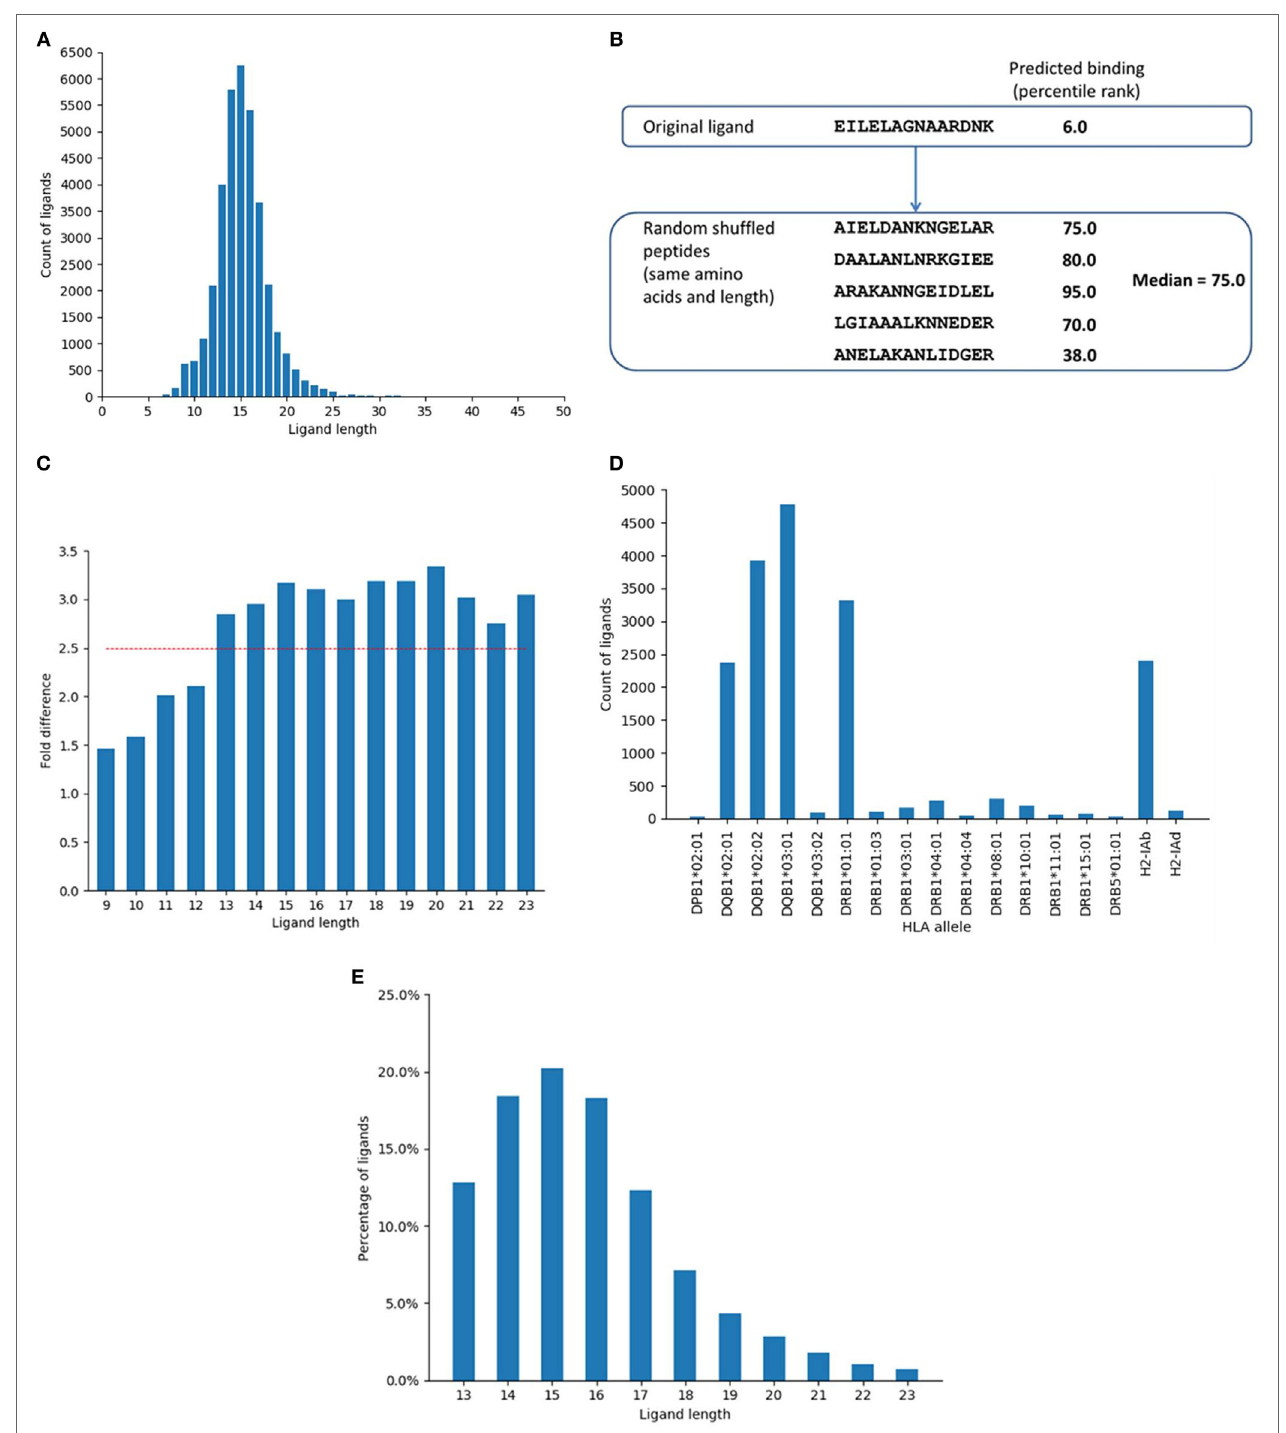
FigUre 1 | Selection of major histocompatibility complex (MHC) II ligand data and distribution of the data. (a) Distribution of ligand entries based on ligand length as collected from immune epitope database. The most abundant length was 15, followed by 14 and 16. Lengths 14–16 comprised around 50% and lengths 13–17 represented around 71% of the ligand data. (B) Example of random peptides generated by shuffling the amino acid residues from a ligand and corresponding predicted MHC II binding (percentile rank). Five random peptides were generated from each ligand by shuffling the component amino acids and the median of the predicted binding (percentile ranks) of the random peptides was assigned as the predicted percentile rank of the random peptide. (c) Fold difference between the proportion of predicted binders among ligands and shuffled peptides for different peptide lengths. The fold difference plateaued after reaching 2.5. The red line indicates fold difference 2.5. (D) Distribution of ligand data based on restricting alleles (only B-chain is shown). (e) Distribution of the ligand data based on final selected lengths.